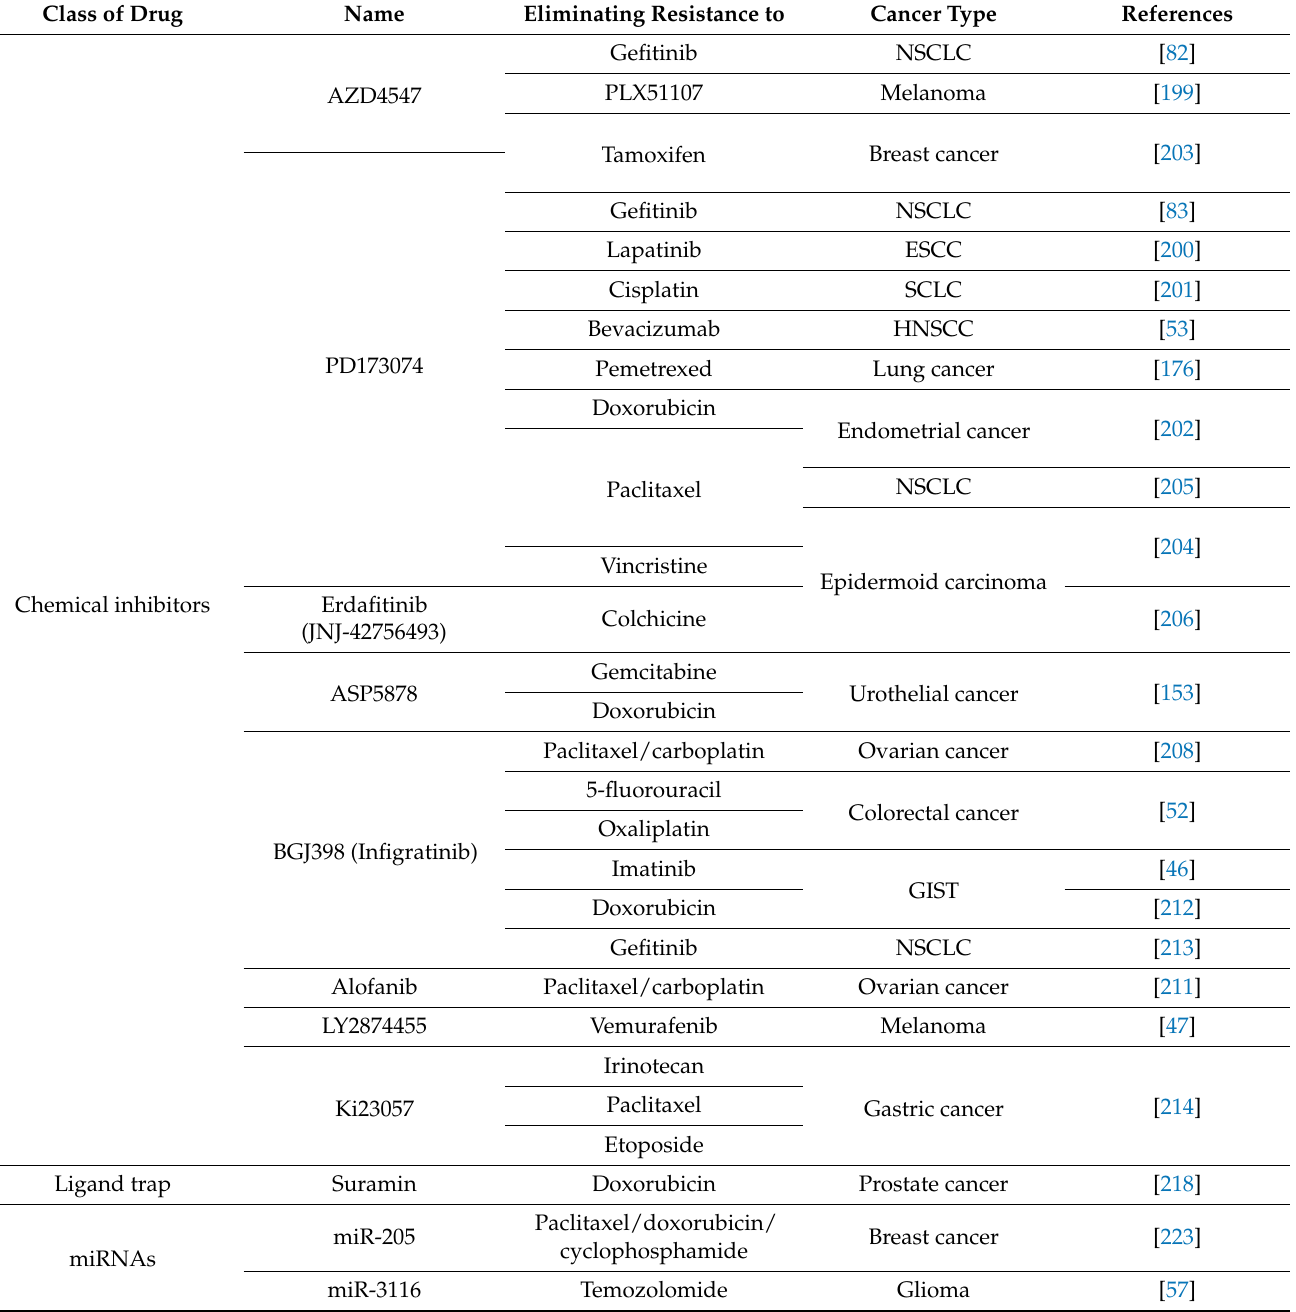
Table 2. Anti-cancer strategies overcoming drug-resistance in FGFR-positive